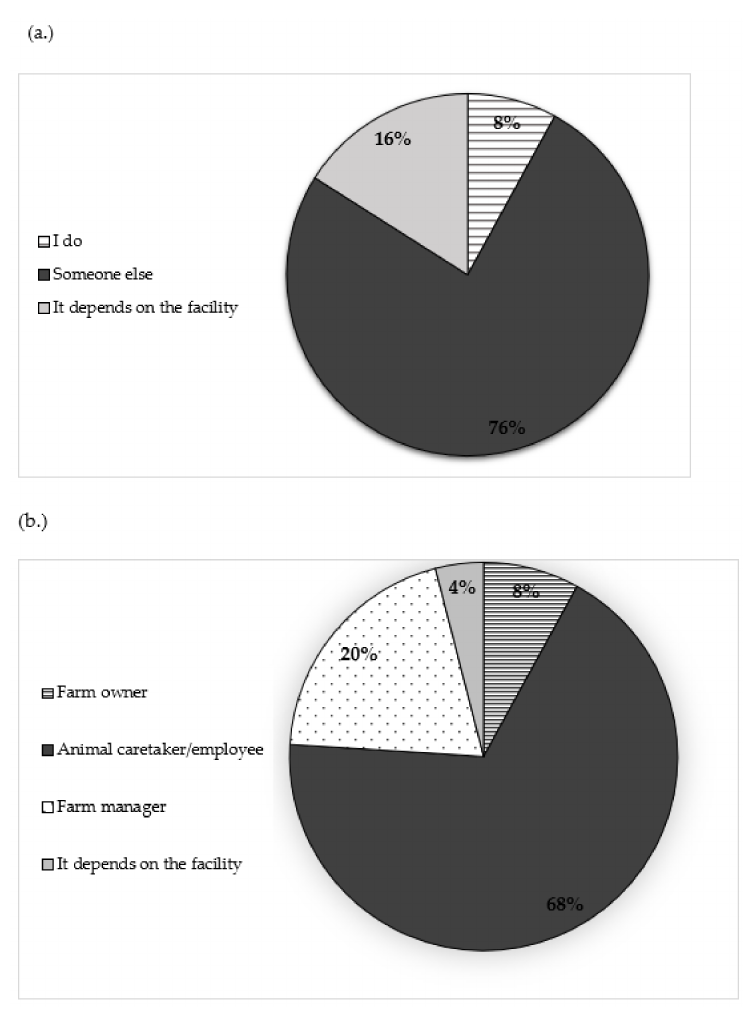
Figure 1. Respondents were asked about decision-making around euthanasia ( n = 25). ( a ) Respondents were asked “On most of the facilities where you serve as a veterinarian, who makes the decision to euthanize?” The options provided for selection were: I do, someone else, it depends on the facility. ( b ) Respondents were asked “If someone else makes the decision to euthanize, what is this person’s role?” The options provided for selection were: farm owner, farm manager, animal caretaker / employee, it depends on the facility, or decline to